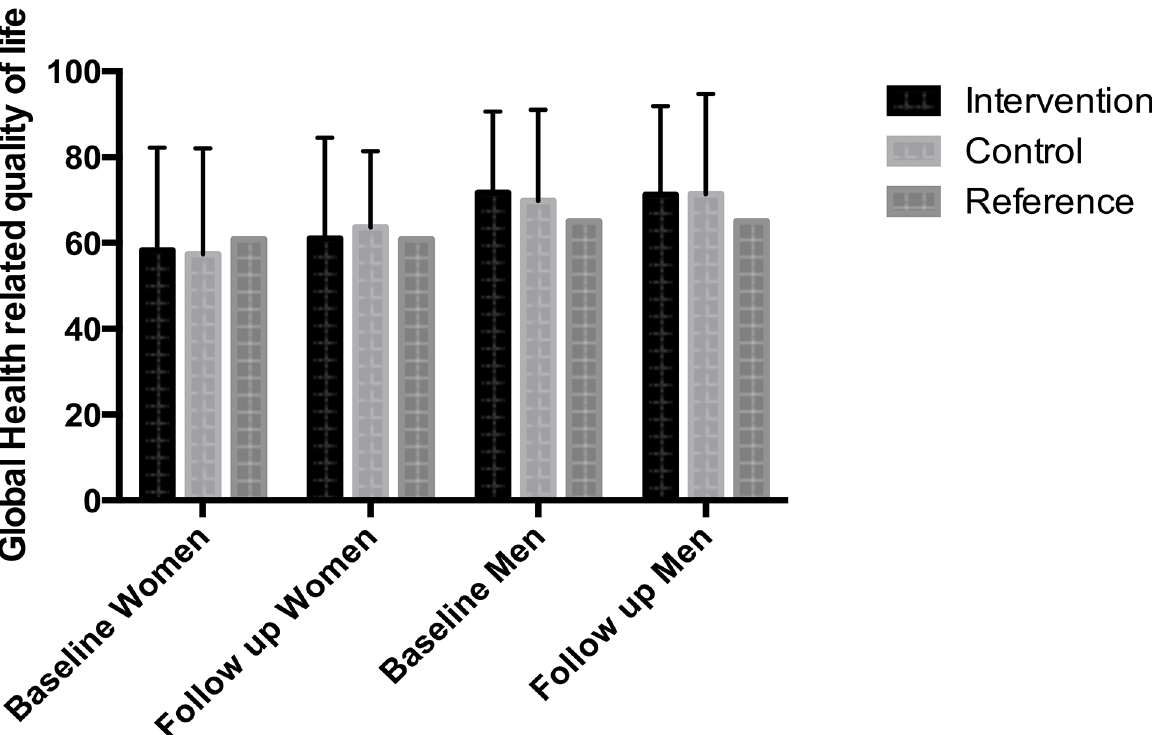
Fig 4. Course of HRQoL. Comparing the baseline and follow-up values for health-related quality of life only for patients who survived and answered the 12 months questionnaire (n = 418), there were neither clinical relevant nor statistical significant differences between baseline and 12 months for HRQoL (intervention women: p = 0.58; men: p = 0.49; control women: p = 0.16; men = 0.29). Compared to age and gender-adjusted reference values for the German population [18], men showed better global health-related quality of life than the reference population with clinical relevance. In contrast, women quoted a lower score of global HRQoL but without clinical relevance.